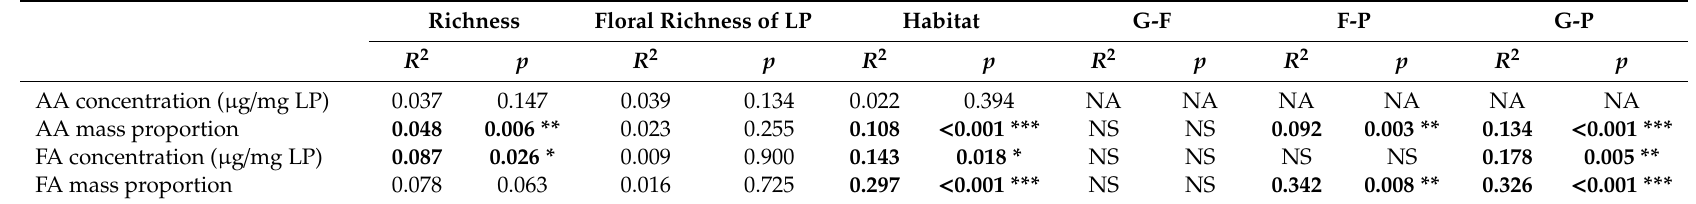
Table 2. Results for permutation tests ( R 2 and p -values) analyzing e ff ects of surrounding plant species richness (Richness) and floral genus richness of larval provisions (Floral richness of LP) and habitat on the composition of amino acids (AA) and fatty acids (FA) (entered as concentrations and mass proportions) in larval provisions (LP) of Tetragonula carbonaria colonies placed in three di ff erent habitats (gardens (G), forests (F) and plantations (P)). Bold values indicate significant e ff ects and asterisks give significance levels following correction for multiple testing using False Discovery Rate (* p < 0.03 ( = FDR alpha), ** p < 0.01, *** p < 0.001). NS—not significant ( p > 0.05). NA—not applicable /